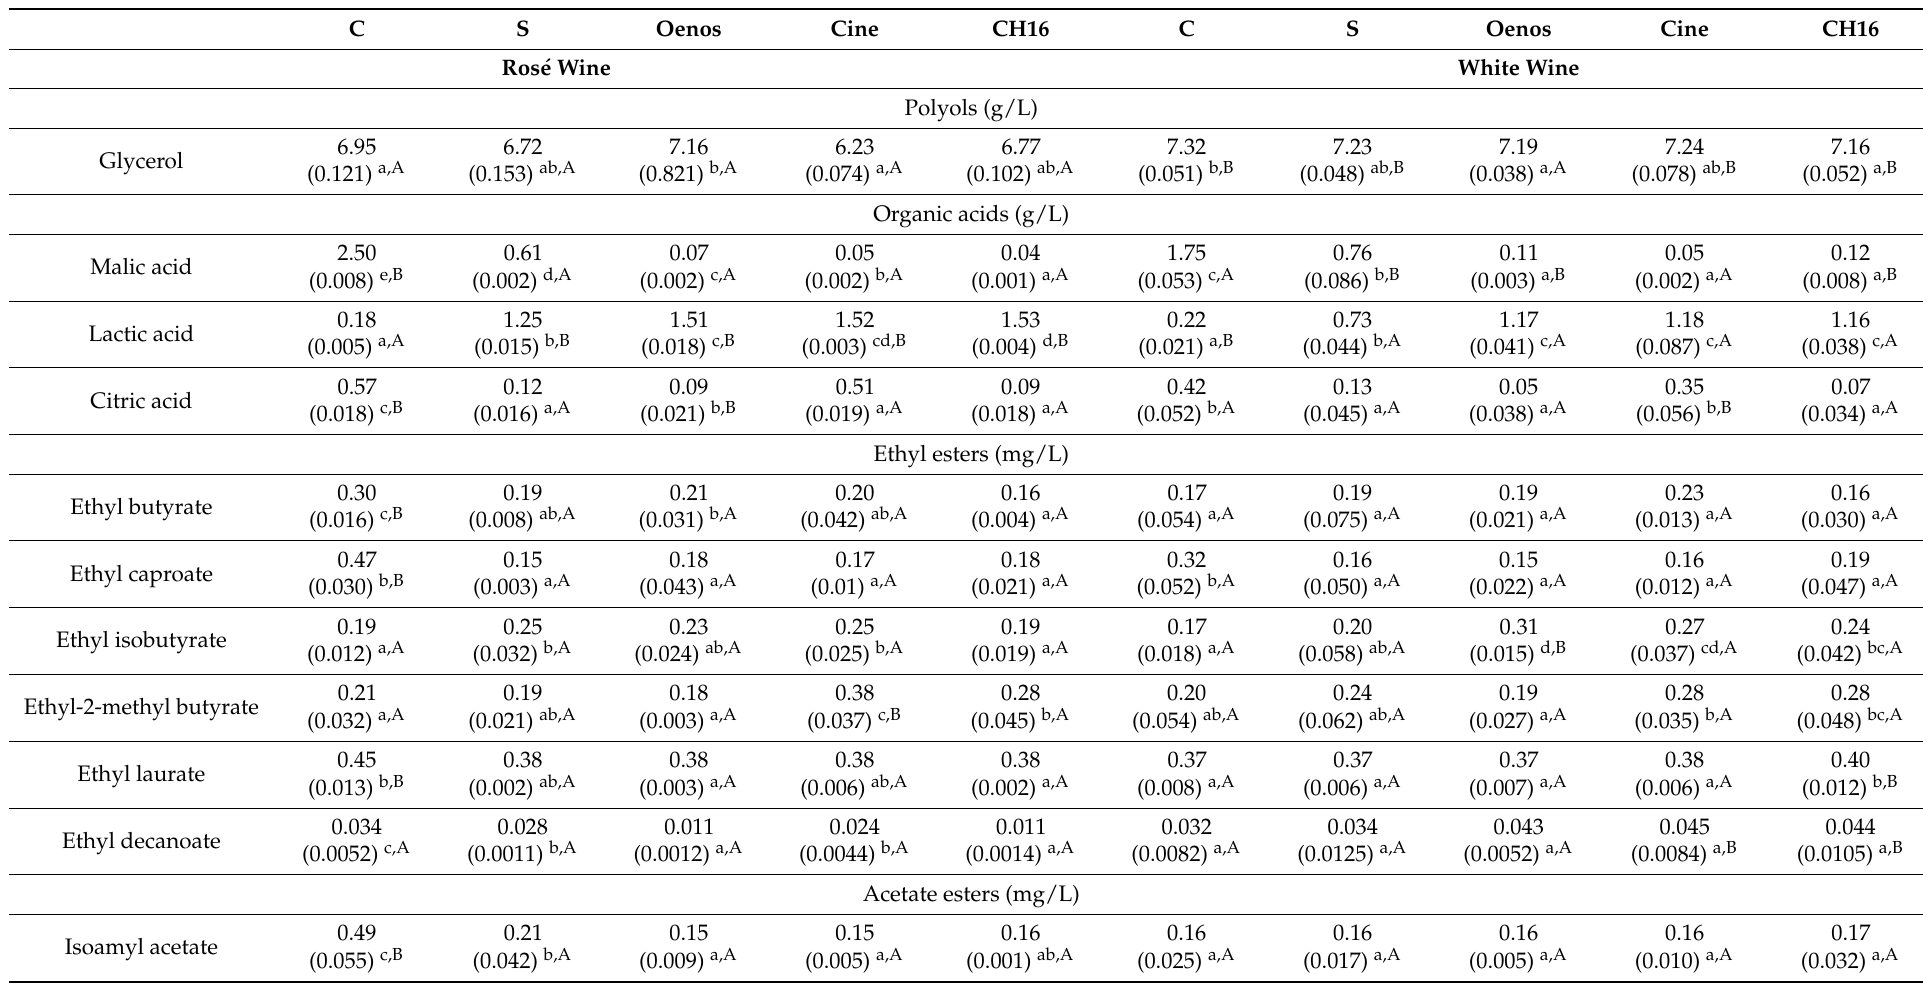
Table 2. Volatile and non-volatile compounds present in the white and ros é wines at the end of AF and